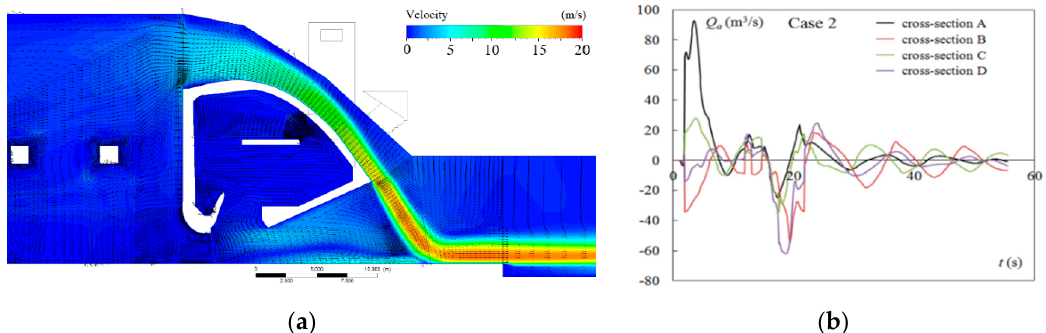
Figure 12. Case 2: ( a ) air-water flow pattern along the right outlet’s centerplane; ( b ) change of Q a as a function of t .